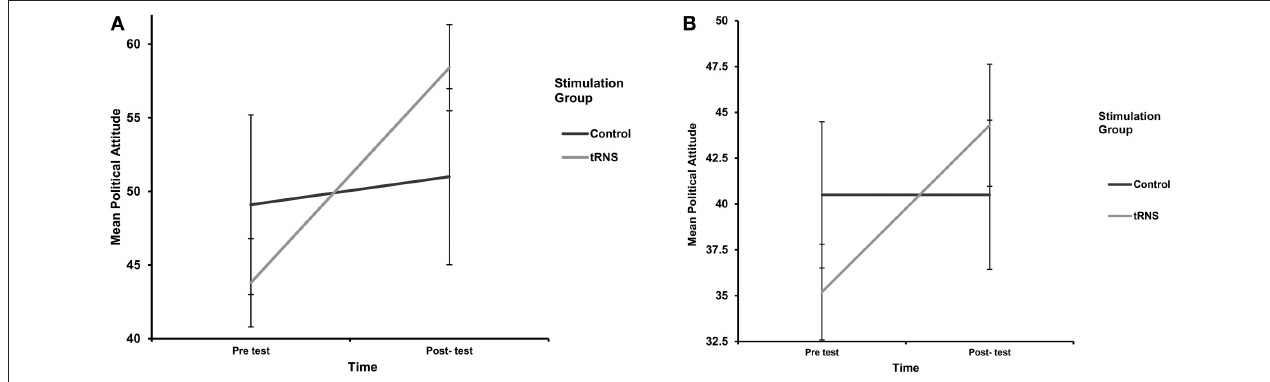
FIGURE 2 | (A) Labor Party Campaign: mean political attitude. (B) Conservative Party Campaign: mean political attitude.